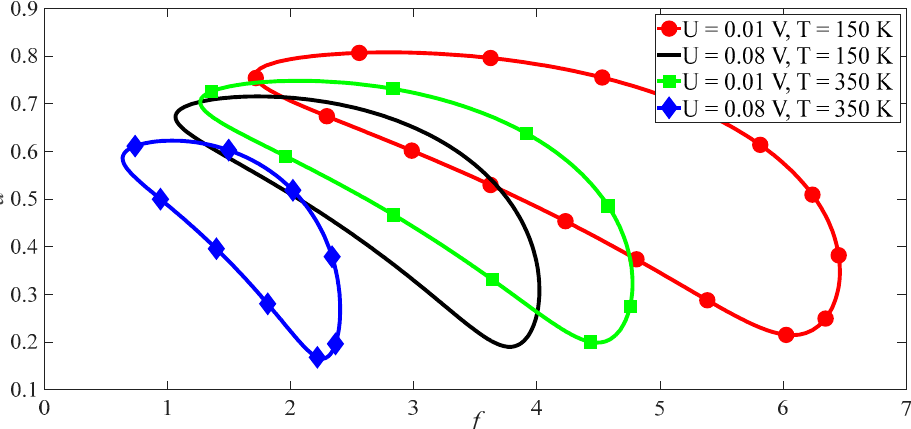
Figure 10. Amplitude excitation curves of the first mode with ( c 1 , σ ) = ( 0.25,80 ) and the second order mode with ( c 2 , σ ) = ( 4, 80 ) .